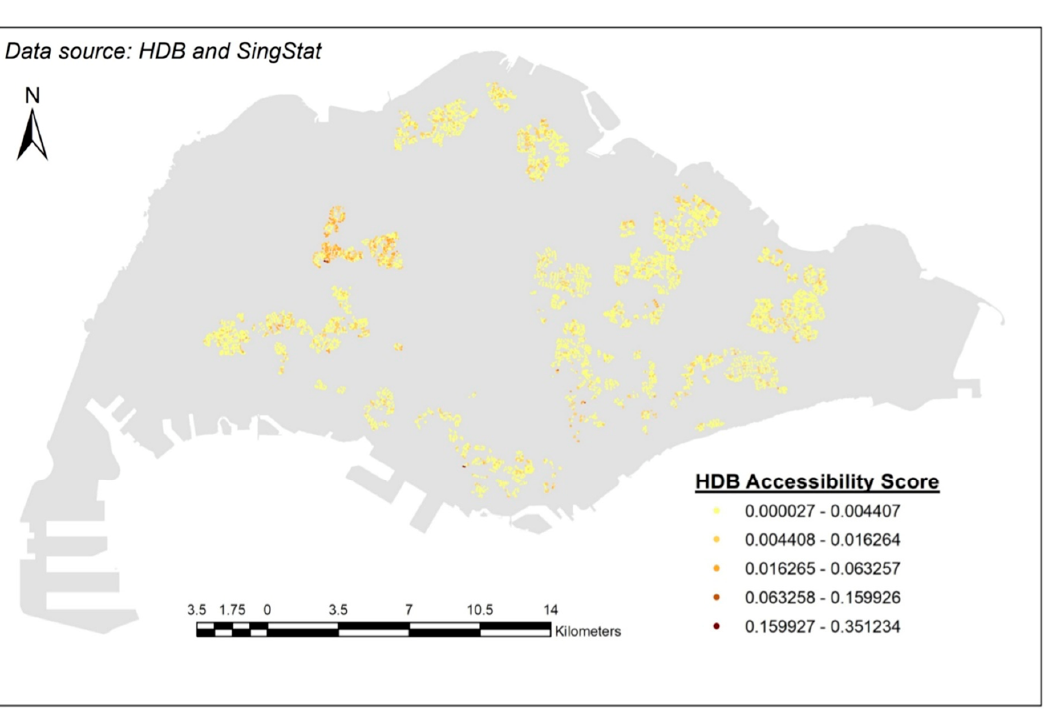
Figure 4. The A i values of each HDB flat.